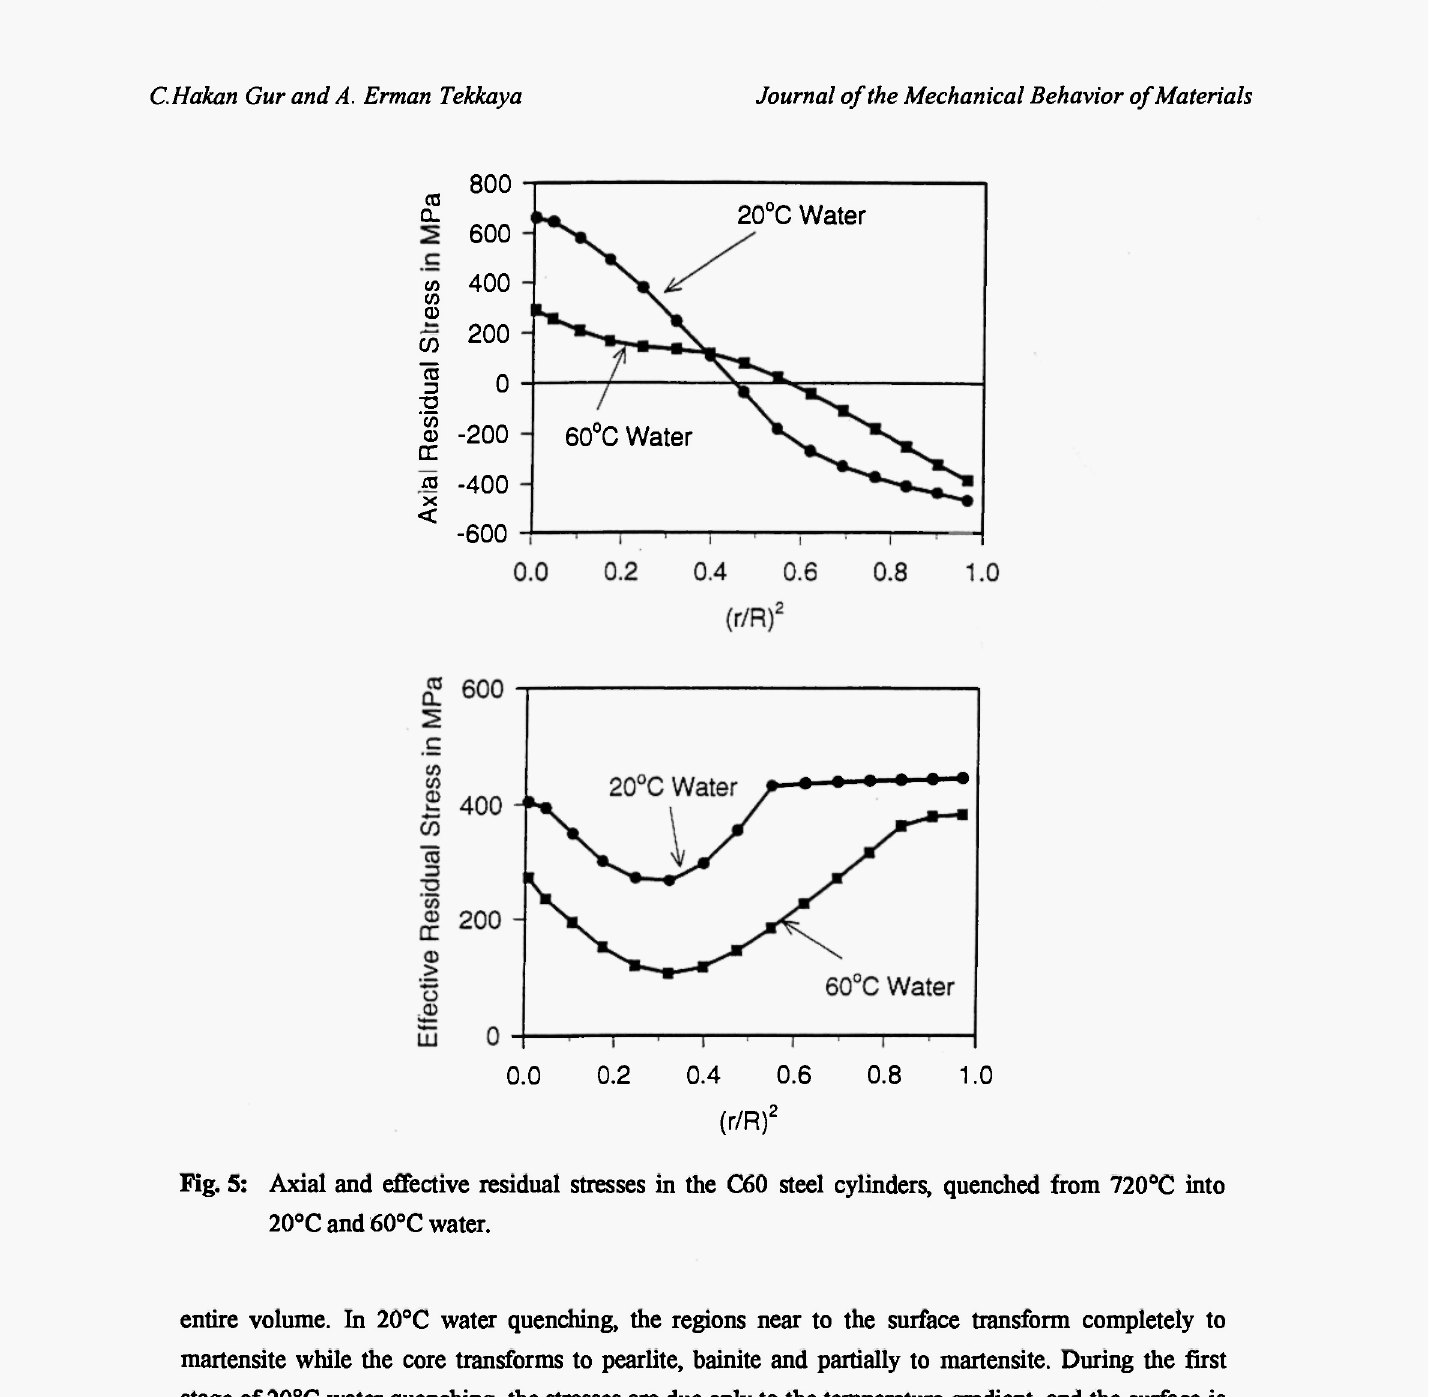
Fig. 5: Axial and effective residual stresses in the C60 steel cylinders, quenched from 720°C into 20°C and 60°C